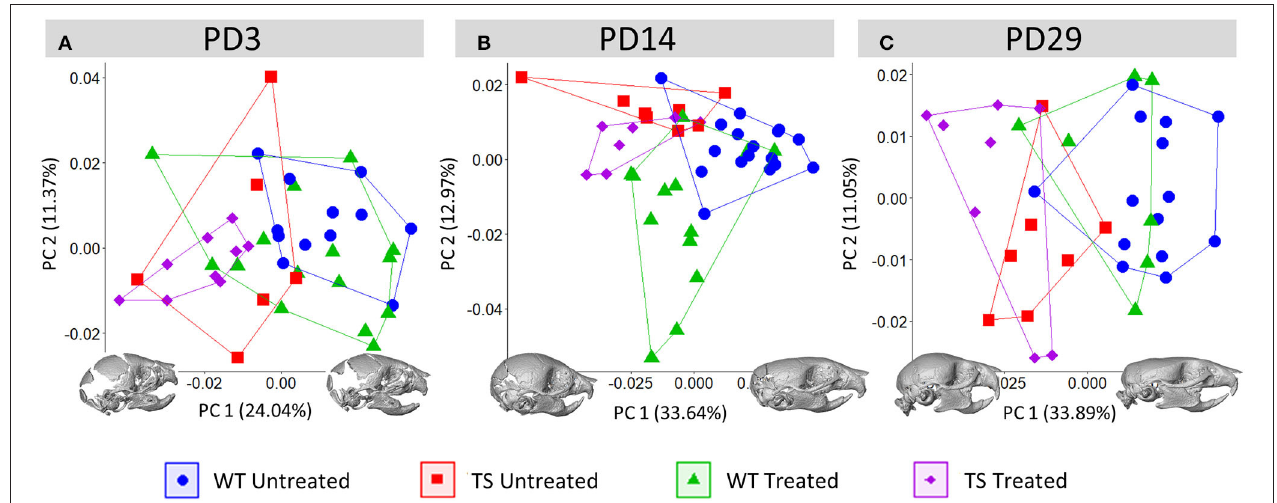
FIGURE 4 | Development of the postnatal skull and facial shape development and effects of GTE-EGCG. Skull shape variation as assessed by a Principal Component Analysis (PCA) based on the 3D coordinates of landmarks placed on the surfaces of 3D renders from in vivo µ CT scans as described in Supplementary Table S5 at (A) PD3, (B) PD14 and (C) PD29. All scatter plots are presented along with the morphings associated with the negative and positive values of the PC1 axis. Morphings are exaggerated to represent a shape associated with a PC score of 0.08 and − 0.08. Sample size: (PD3) WT = 12, TS = 6, WT Treated = 15, TS